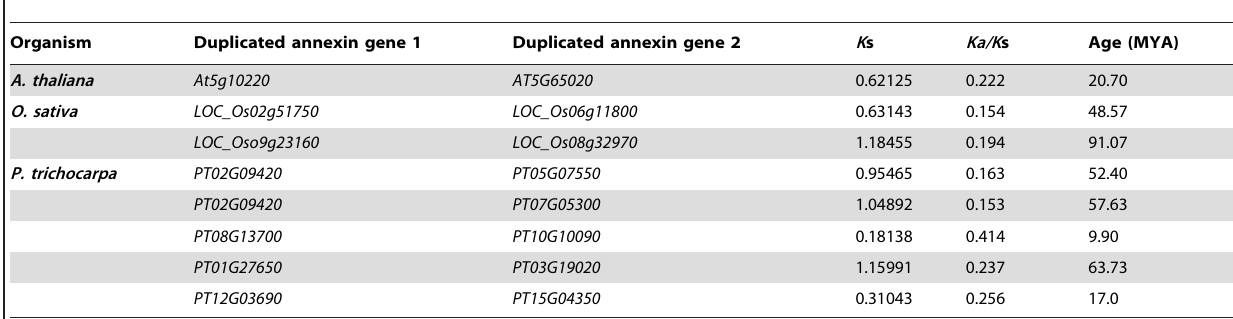
Table 3. Estimation of the age of segmentally duplicated annexin genes in A. thaliana , O. sativa and P. trichocarpa .